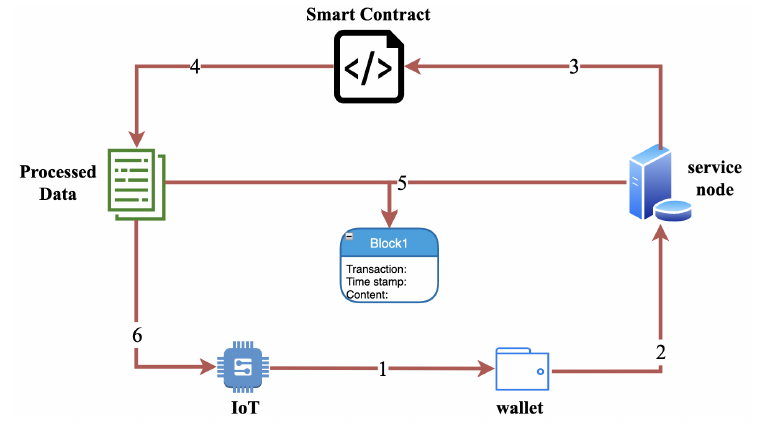
Figure 2. System